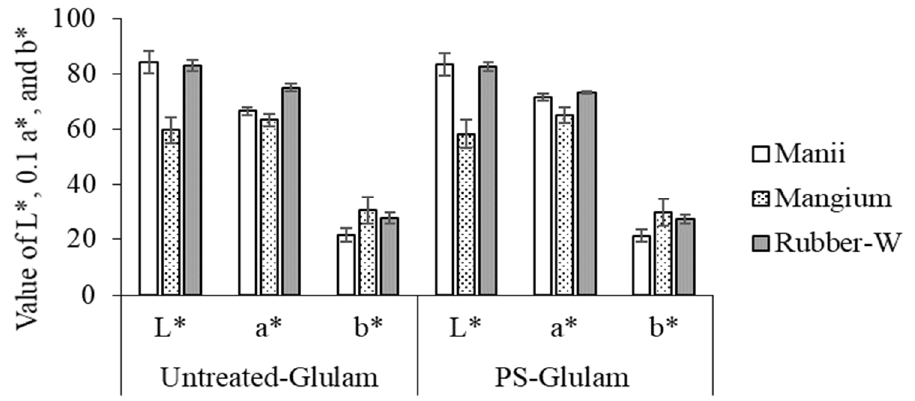
Figure 2. Values of L*, a*, and b* of the glulam. PS =